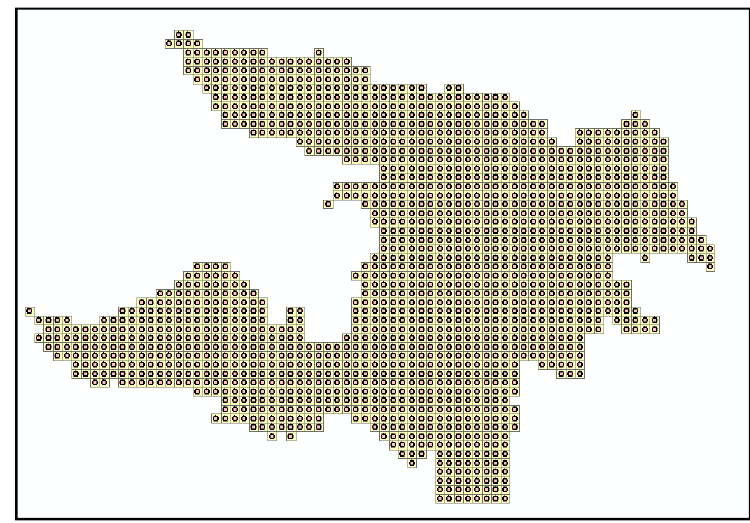
Figure 4. Zhicheng’s grids and their center points after rasterization.